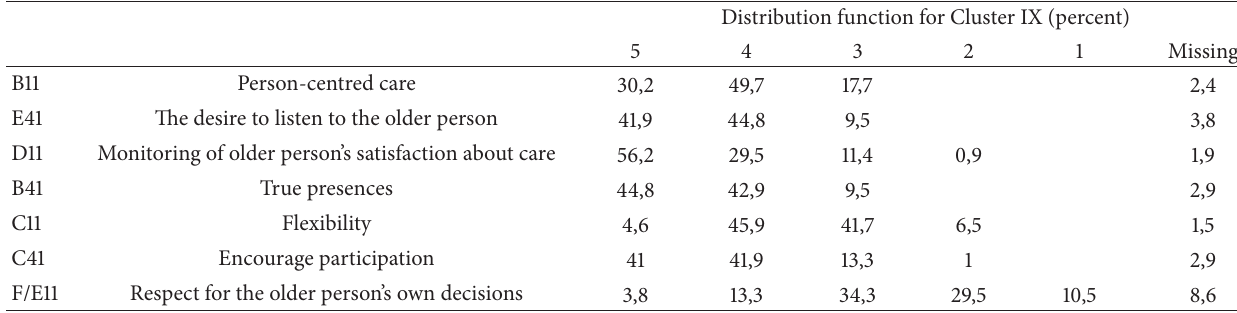
Table 17: Cluster IX: possibilities for caring communion.